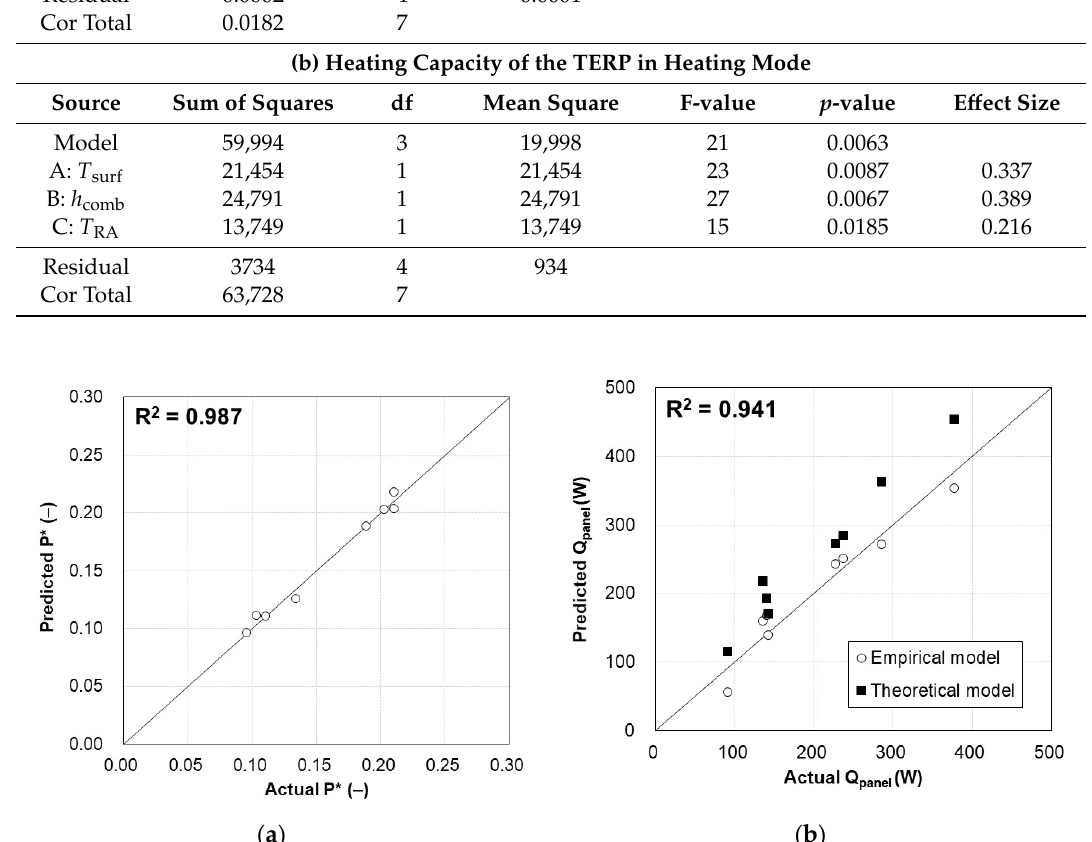
Figure 9. Comparison of the predicted results with experimental results: ( a ) energy consumption of the TERP and ( b ) heating capacity of the TERP.